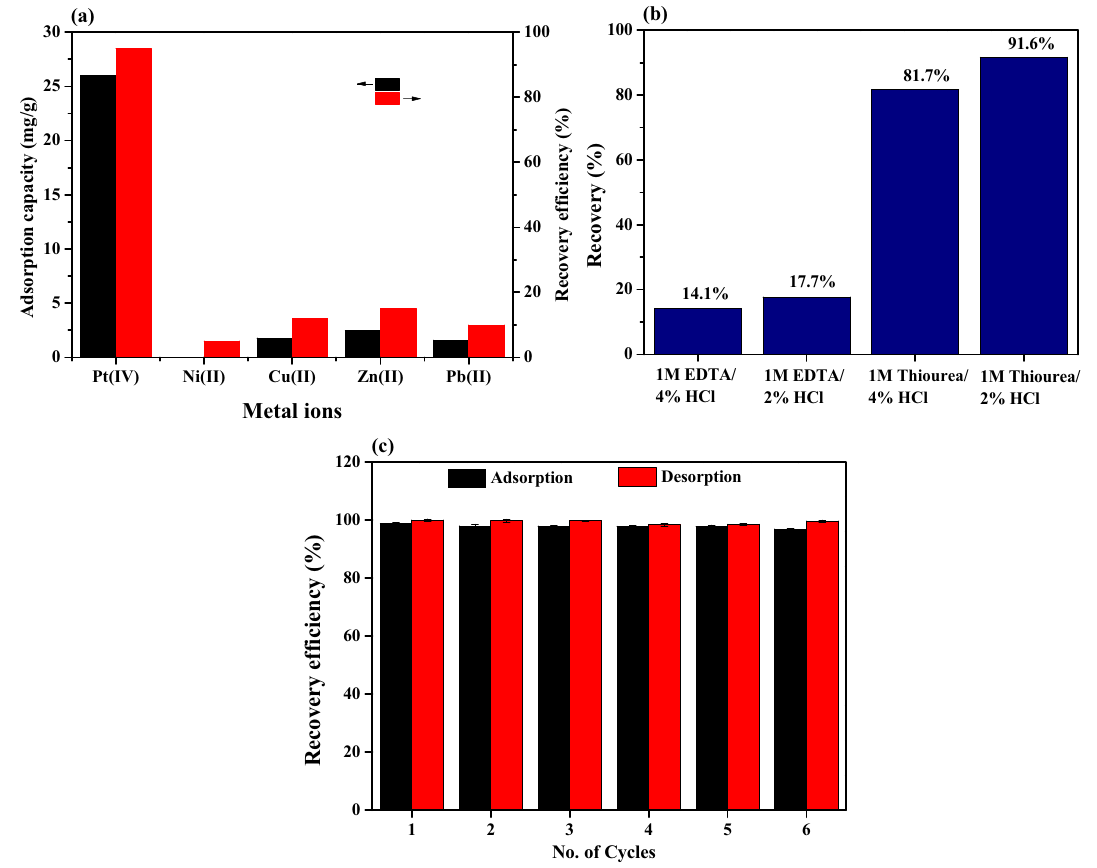
Figure 7. ( a ) Selective adsorption of Pt(IV), ( b ) desorption studies of various solvents and ( c ) regeneration and reusability of Tu–N–SCG–C–A.